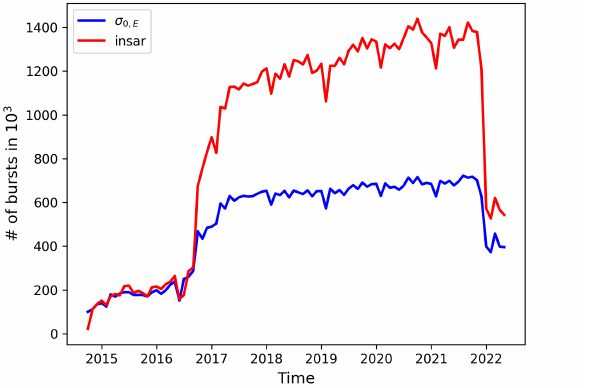
Figure 3. Monthly burst product counts in thousands, in our global scale radar backscatter (blue) and interferogram (red)